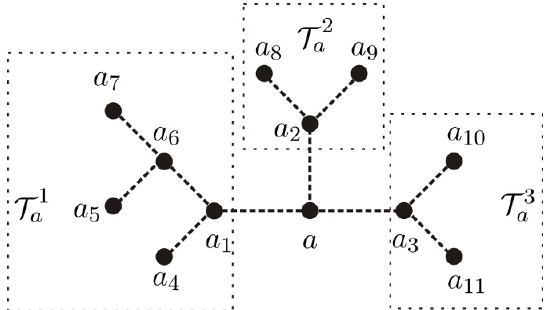
Figure 18 . A tree graph where a is connected with three subtrees T 1